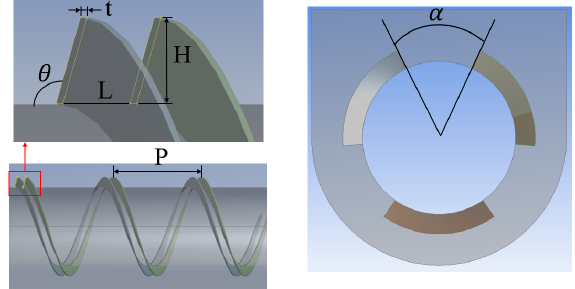
Figure 16. Design parameters relating to blade gap.